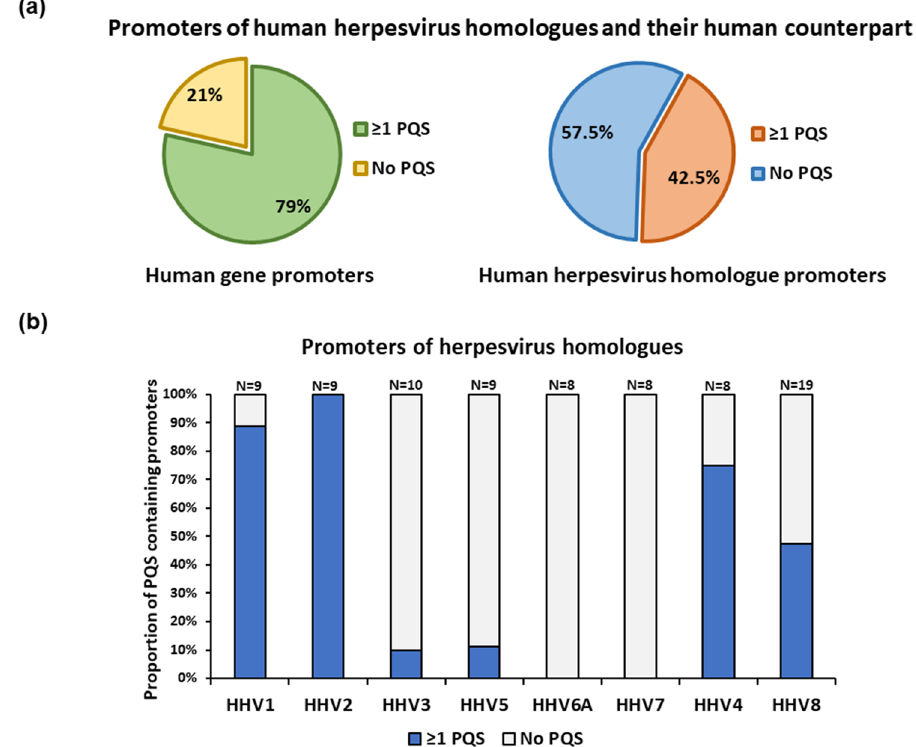
Figure 1. A significant proportion of promoters of human genes captured by herpesviruses and the corresponding virus homologues contain at least one PQS motif. ( a ) Pie charts show the proportion of promoters of human genes (~ 79%) captured by herpesviruses and that of corresponding herpesvirus homologues (~ 42%) with at least 1 PQS motif. ( b ) Bar graph shows the percentage of viral homologues from human herpesviruses with at least 1 PQS motif in their upstream regulatory regions. Promoters of virus homologues from HHV1, HHV2 and gammaherpes viruses (HHV4 and HHV8) were enriched for PQS motifs. N denotes number of virus